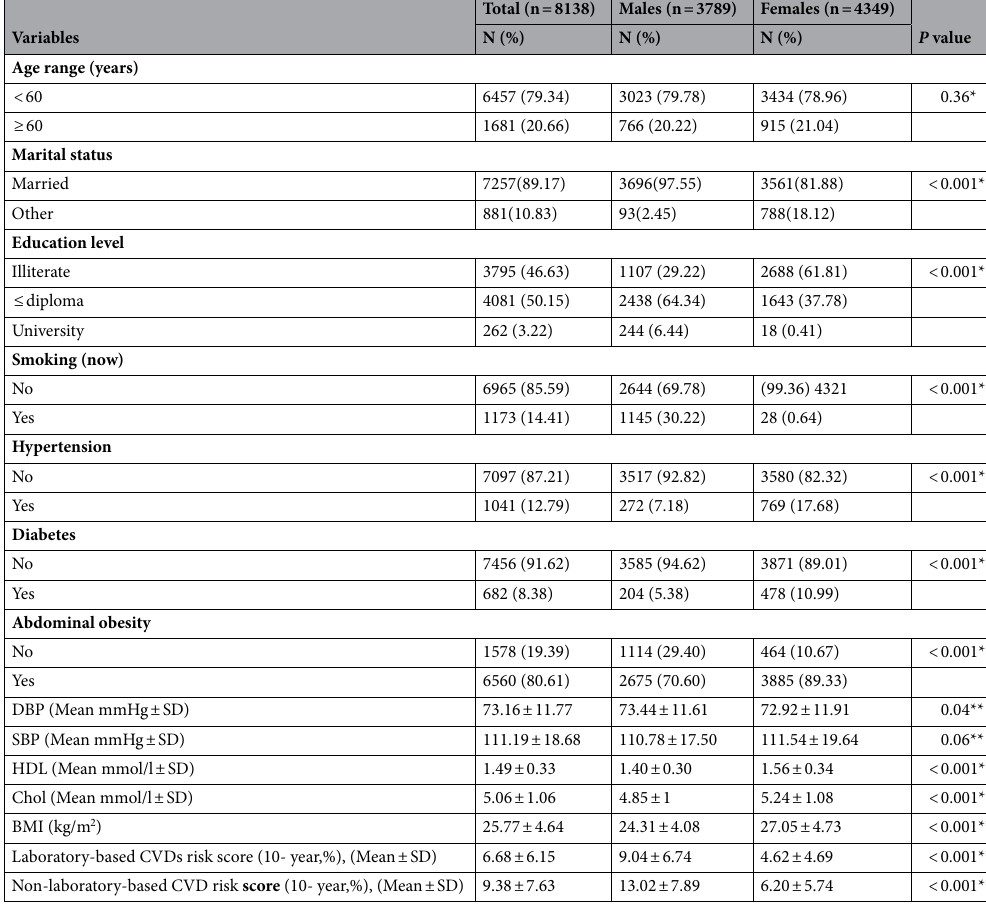
Table 1. Reporting of the participants’ characteristics. DBP diastolic blood pressure, SBP systolic blood pressure, HDL high density lipoprotein, Chol : cholesterol. *chi-square test